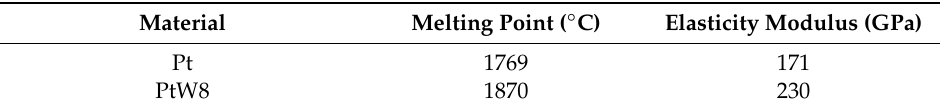
Table 1. Material properties of Pt and PtW8.